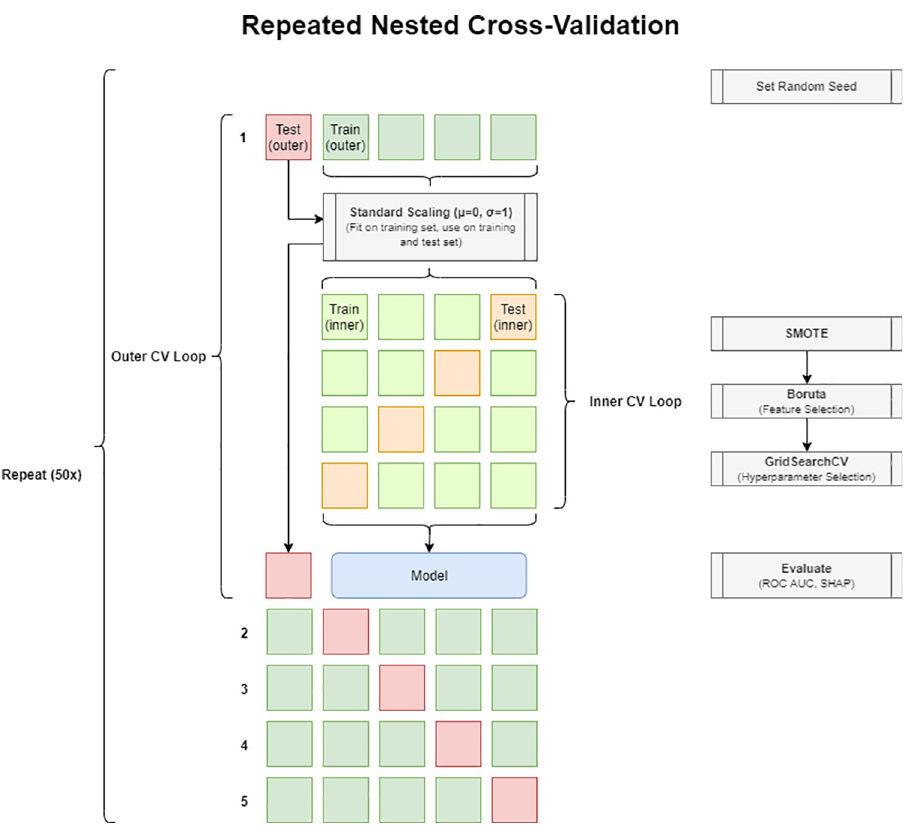
Fig 1. Repeated nested cross-validation process for feature selection, hyperparameter selection, and model evaluation. In each repetition, data is split into 5 folds (1–5). In each fold, 80% are used in an internal CV process for feature selection, hyperparameter optimization, and model training (green squares). The resulting model is tested on the remaining 20% (red square), recording the probability scores and the SHAP values of the random forest model. CV: Cross-validation. SMOTE: Synthetic minority oversampling technique. SHAP: Shapley additive explanations.